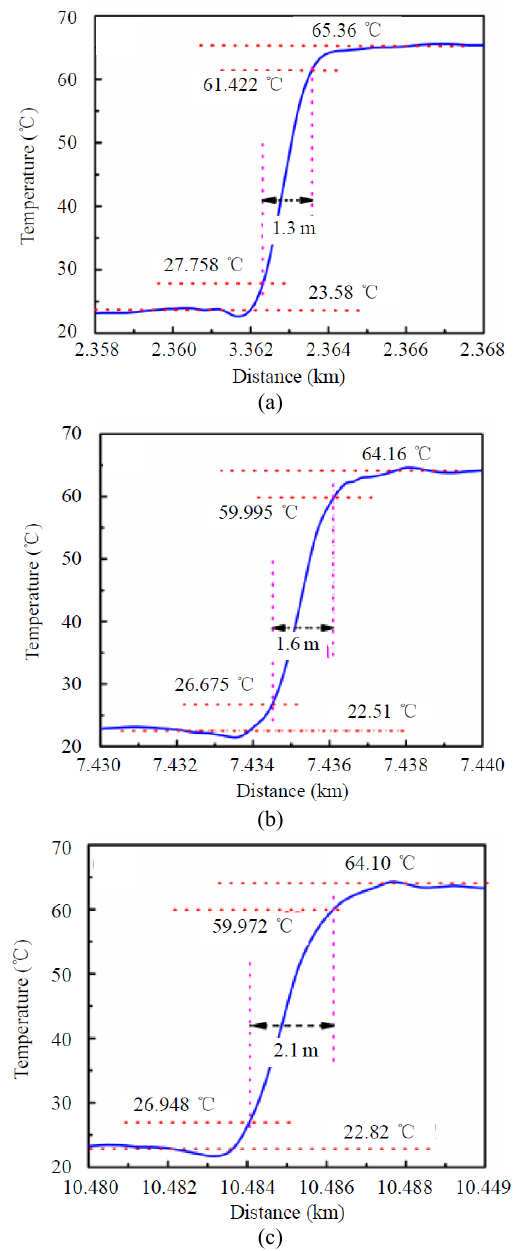
Fig. 9 Spatial resolution at three different test zones of RDTS at: (a) Test 1, (b) Test 2, and (c) Test